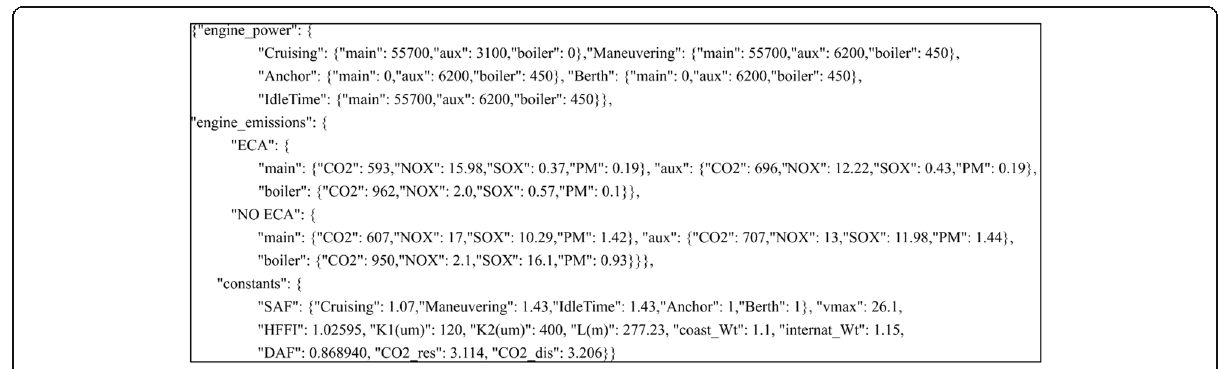
Fig. 3 Example of the JSON input data file regarding engine information. This information is used to estimate fuel consumption and GHG emissions using the models proposed in [21]